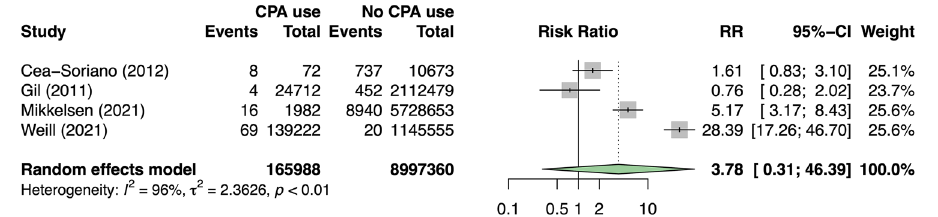
Figure 2. Forest plot demonstrating the association between CPA use and intracranial